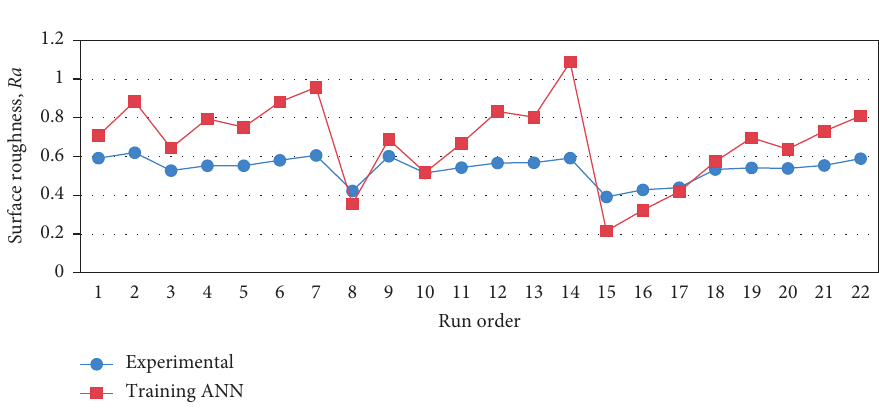
Figure 2: Matching of experimental and ANN values for surface roughness training